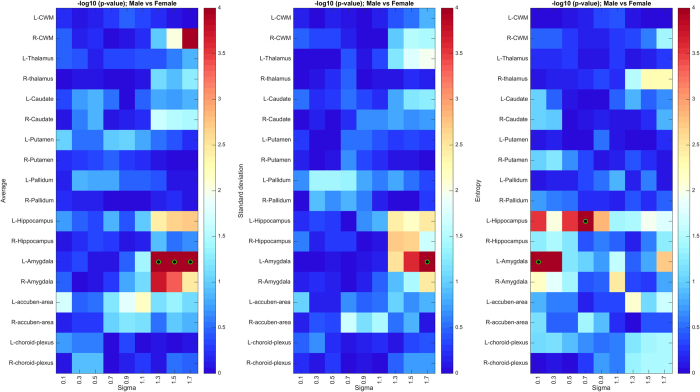
Significance of male vs female (uncorrected p-values, −log10 scale) in selected regions, for various filter scales (sigma), following exclusion of 52 volumes based on ABIDE QA.Green-black circles indicate region-scale values with significant p-values following Holm-Bonferroni correction.